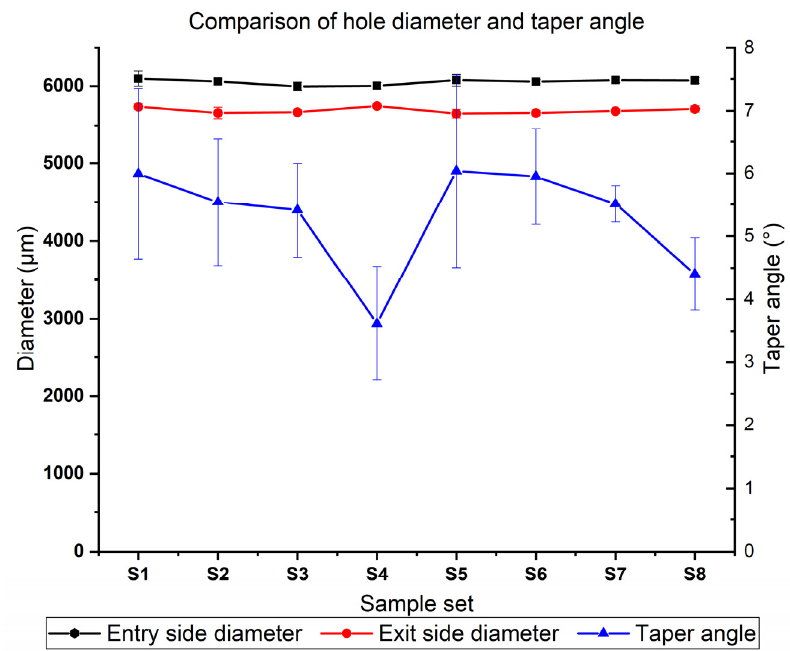
Figure 9. Comparison of hole diameter and taper angle via stepped laser parameter multiple-ring drilling method and constant laser parameter multiple-ring drilling method.